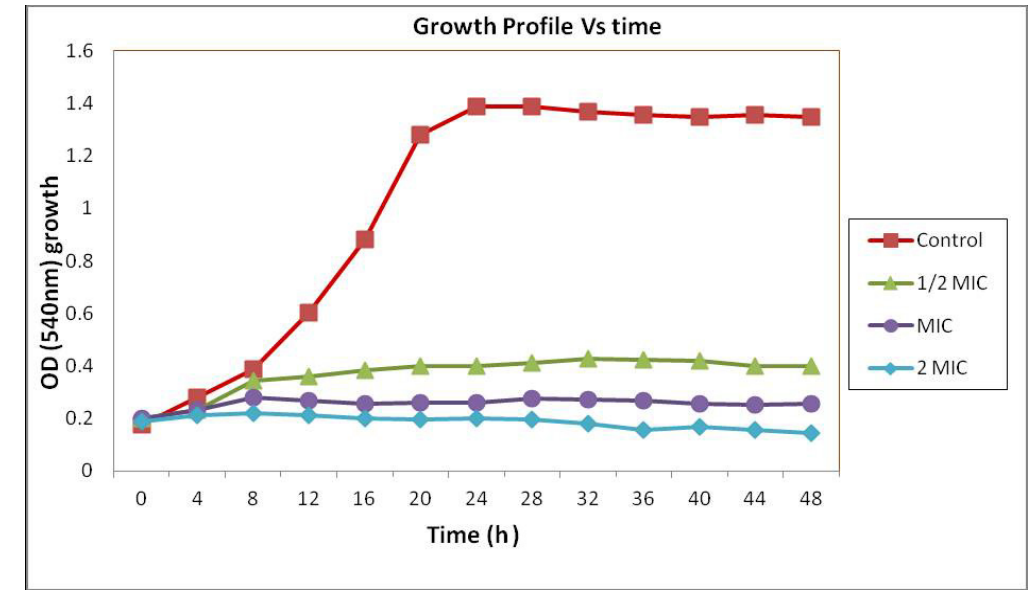
Figure 1. Growth profile of Candida albicans in Muller Hinton broth with 0 (control) and 3.13 mg/mL (1/2 MIC), 6.25 mg/mL (MIC) and 12.5 mg/mL (2 MIC) concentration of C. fistula seed